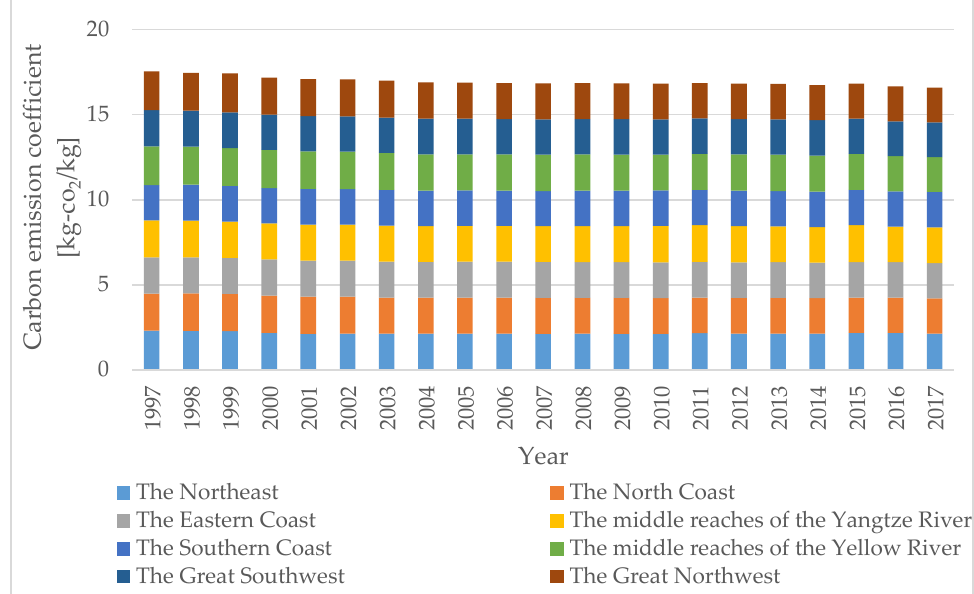
Figure 3. Carbon emissions coefficients of different regions in China from 1997 to 2017.